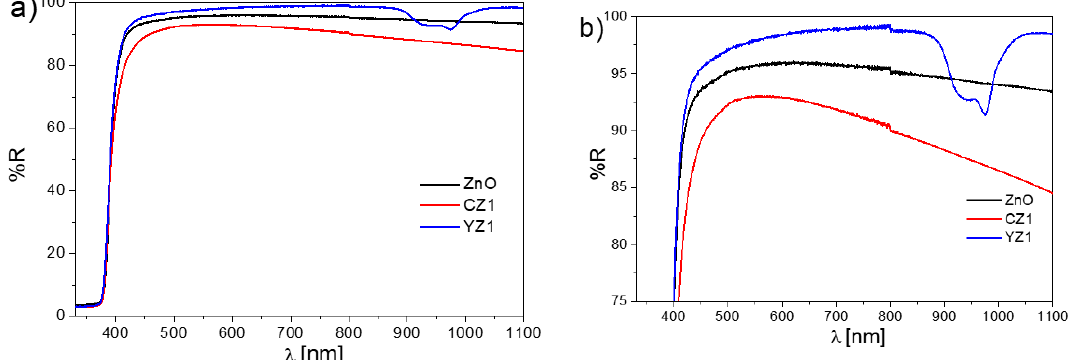
Figure 2. ( a ) Percentage of reflectance spectra of ZnO (black line), CZ1 (red line) and YZ1 (blue line); ( b ) enlargement of panel ( a ).